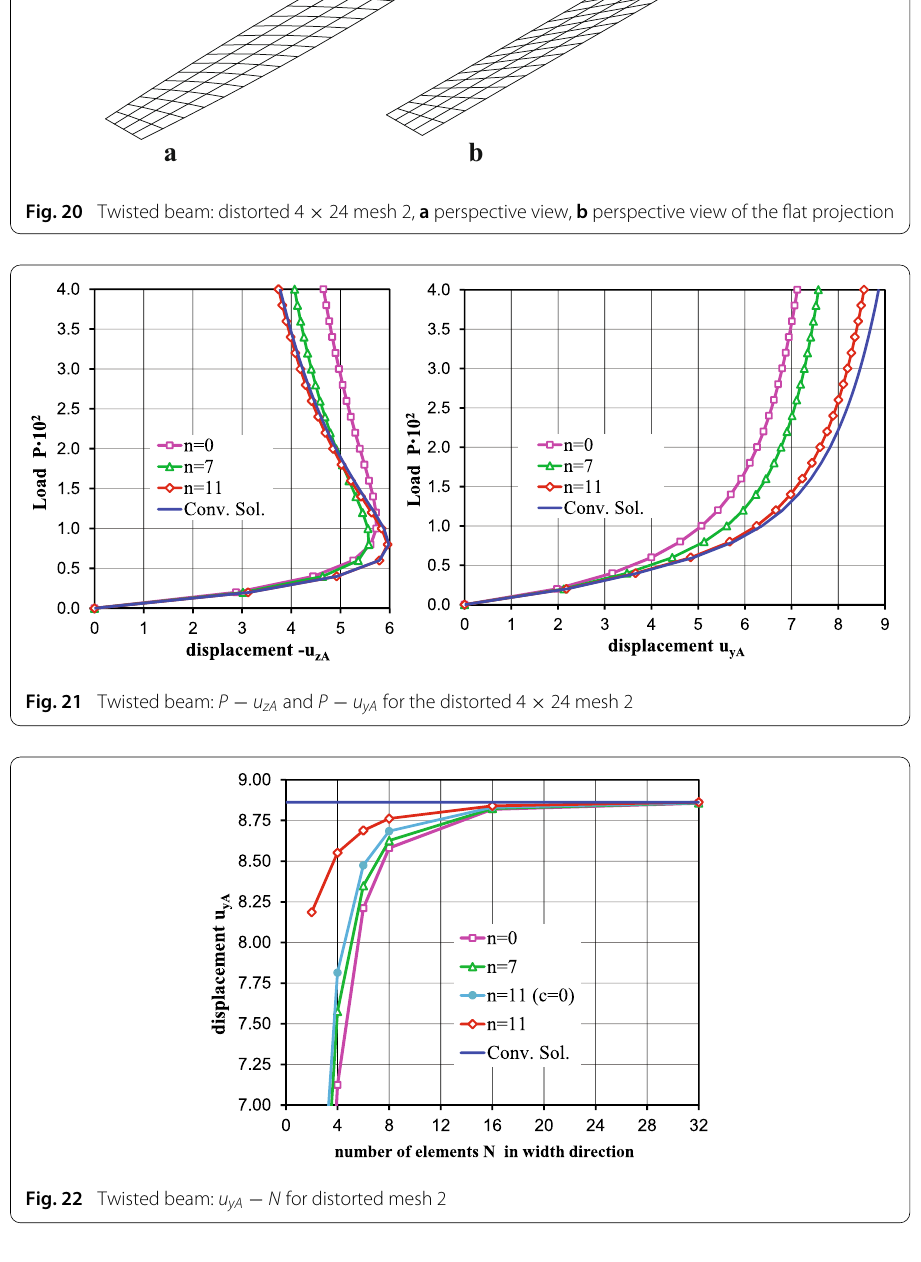
elements in width direction, 2 N elements for the first arch ( R 1 ) and 3 N elements for the second arch ( R 2 ), see Fig. 24. Geometrical and material data are R 1 = 14 , ϕ 1 = 60 ◦ , R 2 = 46 , ϕ 2 = 150 ◦ , b = 20, thickness h = 0 . 02 and E = 3 . 3 · 10 3 , ν = 0 . 3,